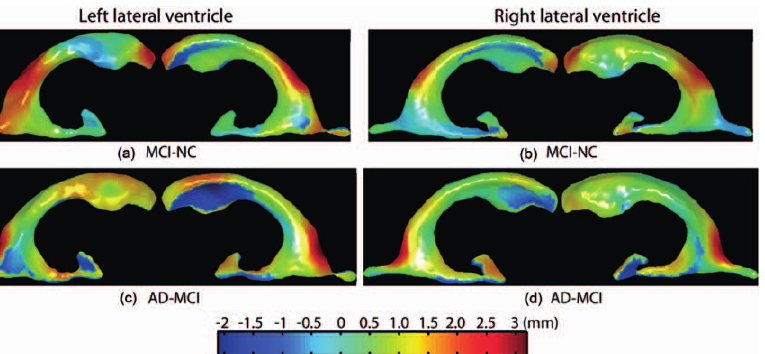
Figure 3. Shape differences of the lateral ventricles among normal controls (NC), mild cognitive impairment (MCI), and Alzheimer’s Disease (AD). Panels (a,b) respectively show group differences in the left and right lateral ventricular surface deformations between MCI and NC. Panels (c,d) respectively show group differences in the left and right lateral ventricular surface deformations between AD and MCI. Warm color denotes regions where structures have surface outward-deformation in the former group when compared with the latter group, while cool color denotes regions where structures have surface inward-deformation in the former group when compared with the latter group.